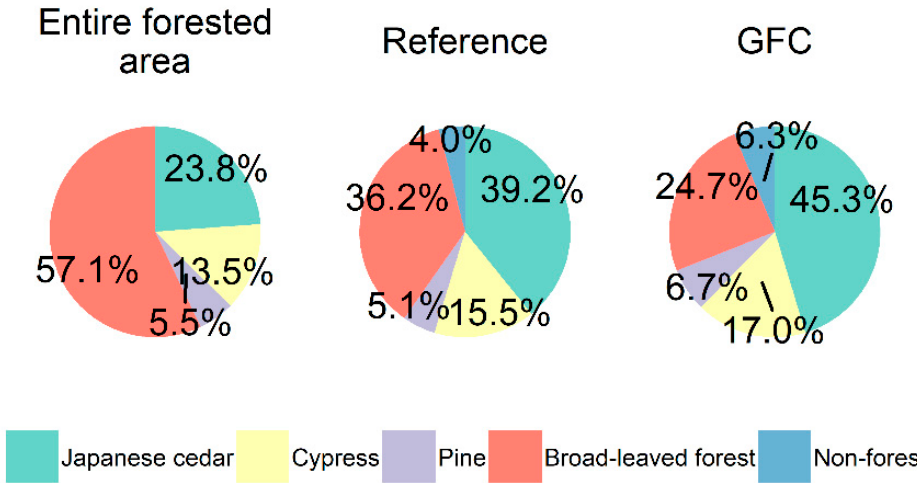
Figure 7. Comparison of the proportions of forest type in the entire forested part of the study area in 2014 (reference dataset) with those in areas of forest loss from 2014 to 2016 derived from the GFC and reference datasets.